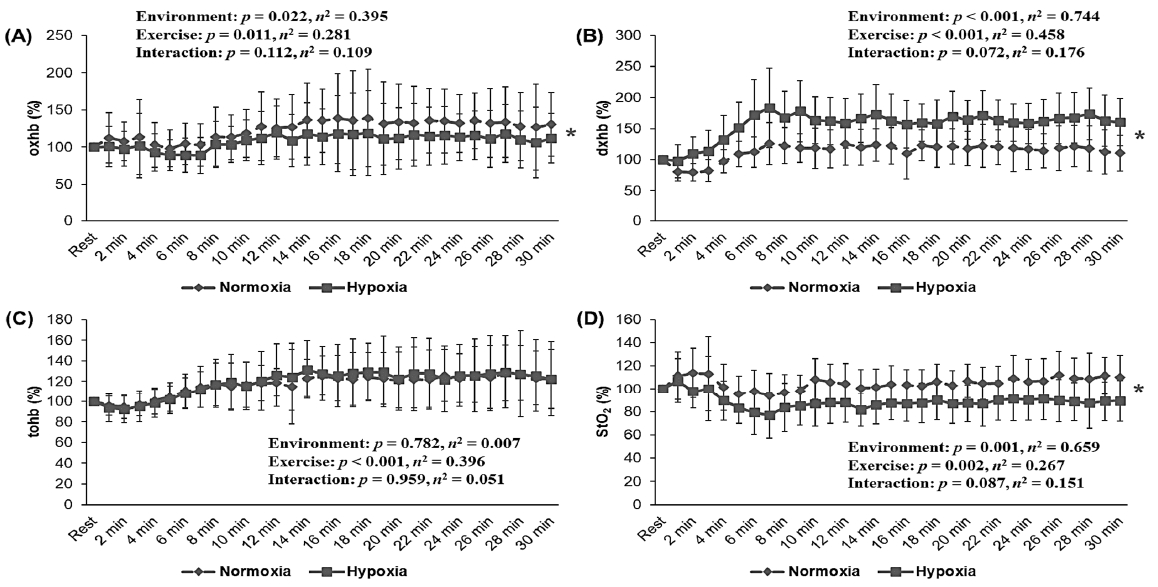
Figure 5. Changes in skeletal muscle oxygenation during 30 min of endurance exercise at the same relative exercise intensity (70%HRmax) under normoxia (760 mmHg) and hypoxia (526 mmHg, sim- ulated 3000 m). ( A ) oxhb, ( B ) dxhb, ( C ) tohb, ( D ) StO 2 . HRmax: maximal heart rate; oxhb: oxygenated hemoglobin; dxhb: deoxygenated hemoglobin; tohb: total hemoglobin; StO 2 : tissue oxygenated